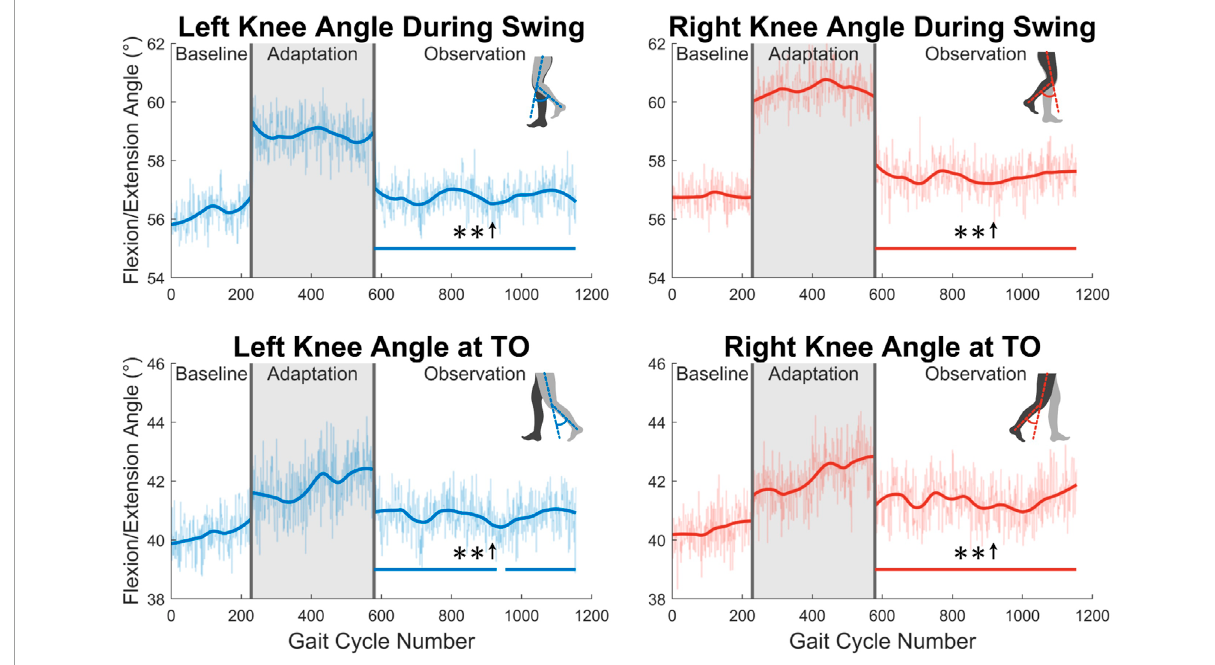
FIGURE 8 The top two graphs display maximum left and right knee flexion/extension angle during the swing phase. The bottom two graphs show knee flexion/extension angle at the instant that toe-off occurs. Significance is shown in the observation phase as compared to the baseline phase by the significance line. All significance testing was performed on “unsmoothed” data (seen in the lighter line). The darker line is the data smoothed by 2nd-degree polynomial local regression and was added only to allow the reader to more clearly see trends in the